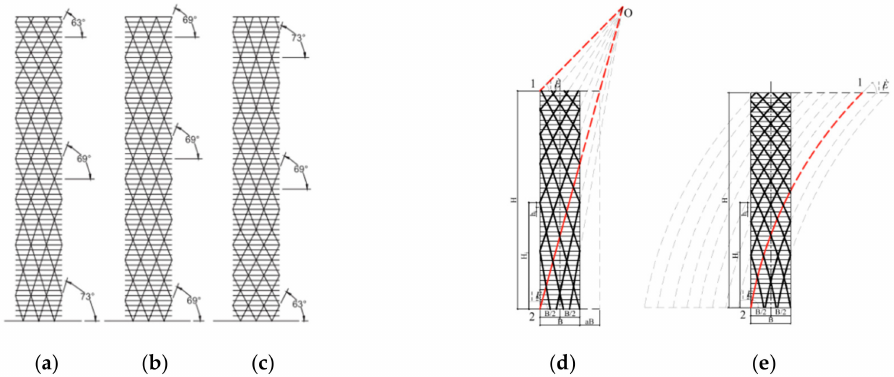
Figure 8. Di ff erent diagonal angle patterns diagrids: ( a ) varying-angle with steeper diagonals at the base; ( b ) uniform-angle; ( c ) varying-angle with steeper angle at the top, used with permission from Moon [12]; ( d ) varying-angle with straight diagonals; ( e ) varying-angle with curved diagonals, used with permission from Zhao and Zhang